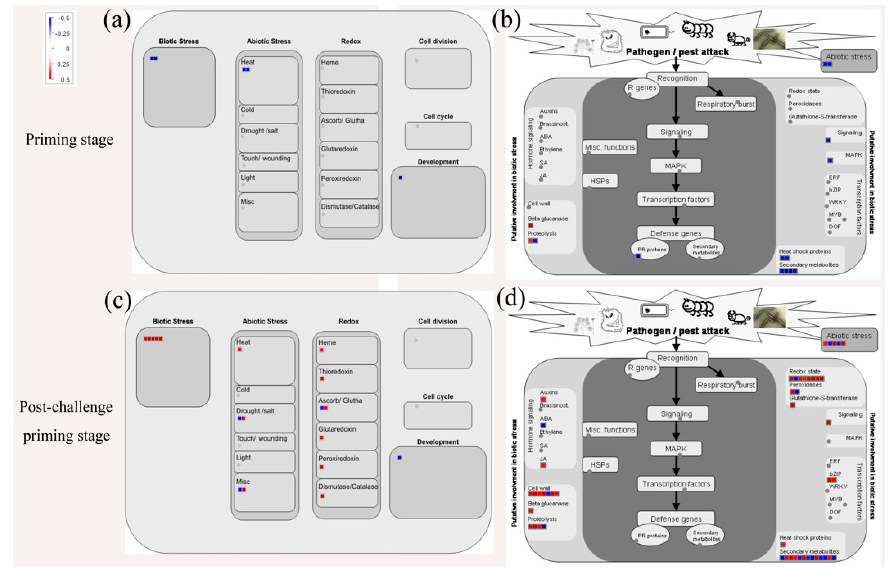
Figure 6. Proteins that were differentially regulated in BABA-primed fruit at priming stage and post- challenge priming stage were graphically analyzed and visualized using the MapMan. Proteins that were differentially regulated in BABA-primed fruit at priming stage involved in cell defense ( a ) and biotic stress ( b ); proteins that were differentially regulated in BABA-primed fruit at post-challenge priming stage involved in cell defense ( c ) and biotic stress ( d ). Up-regulated proteins were presented in red while down-regulated proteins in blue.